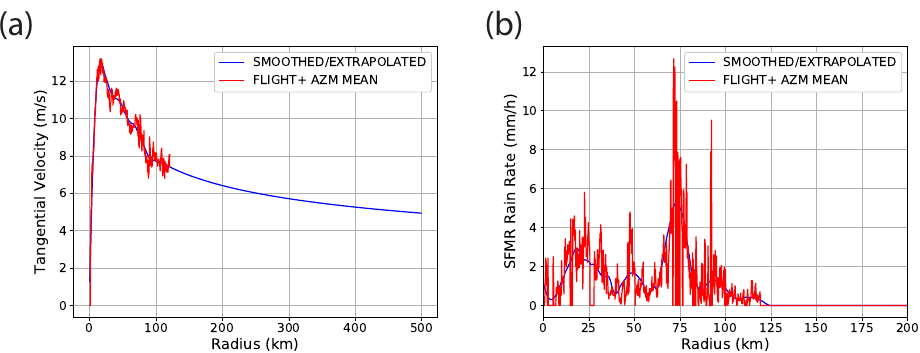
Figure 6. Hurricane Dorian (2019) azimuthal mean group 4 (valid 1205 UTC 28 August 2019). ( a ) Azimuthal mean FL tangential velocity. ( b ) Azimuthal mean SFMR rain rate. In each panel, the raw FLIGHT+ Dataset azimuthal means are in red and the smoothed and extrapolated curves are in